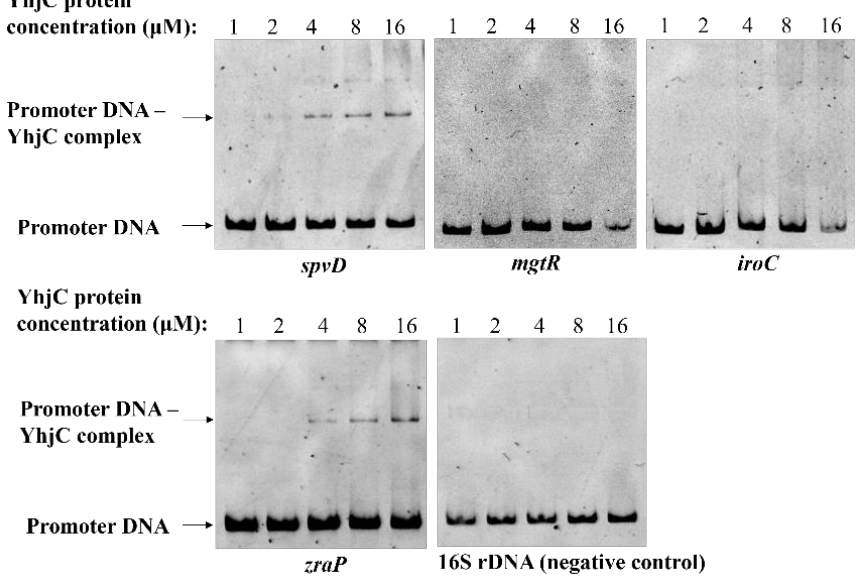
(cid:48) intergenic region DNAs of target